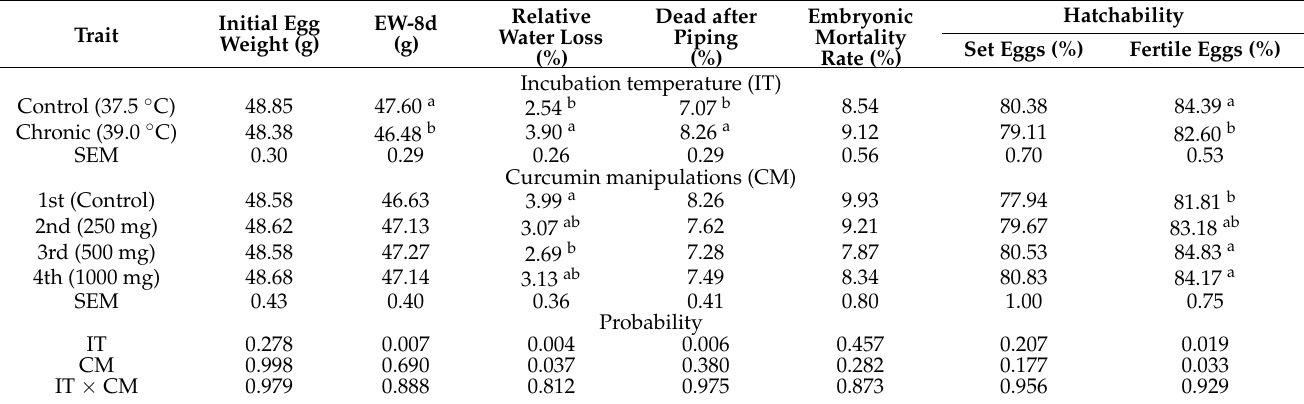
Table 1. Impact of incubation temperature, curcumin manipulations, and their interaction on relative water loss and embryonic mortality and